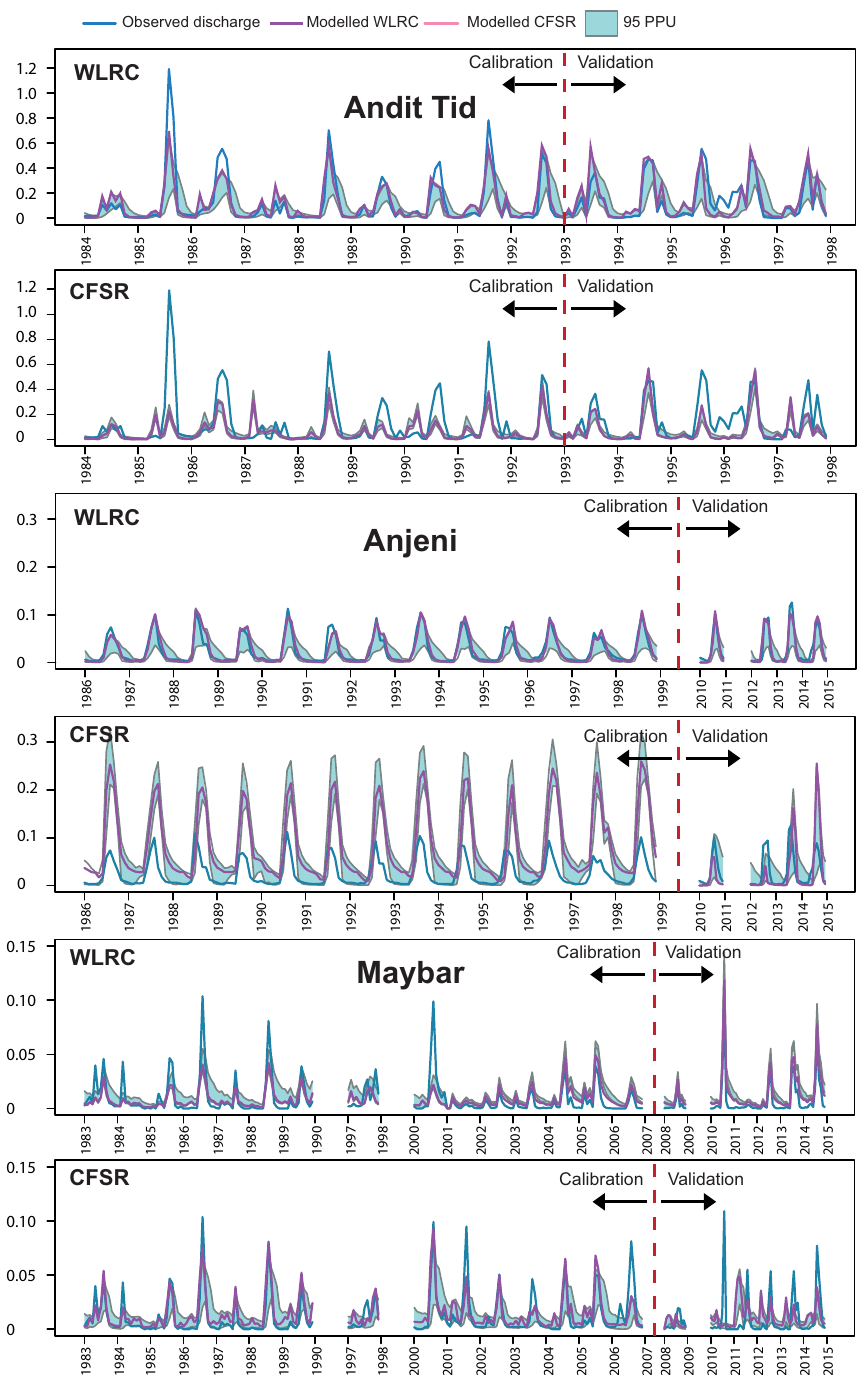
Figure 3. Modelled SWAT discharge compared to measured discharge (blue) for WLRC (violet) and CFSR (pink) input data and 95% prediction uncertainty (light blue). Each sub-figure contains the calibration and the validation period. Results are given in m 3 s − 1 .